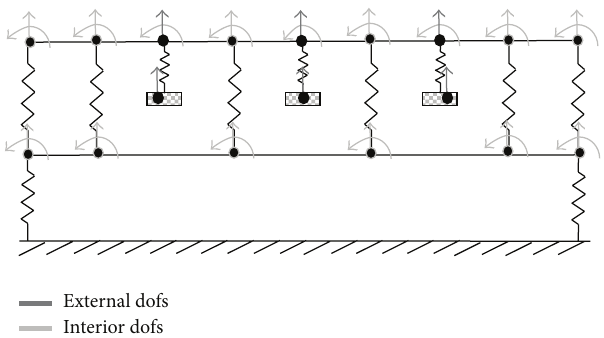
Figure 6: Finite element model of the vibratory feeder investigated.